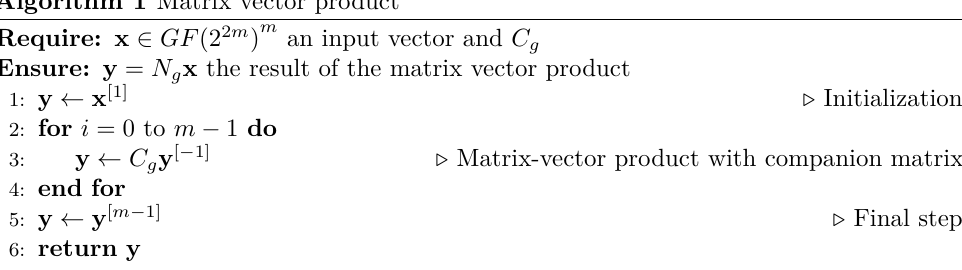
Algorithm 1 Matrix vector